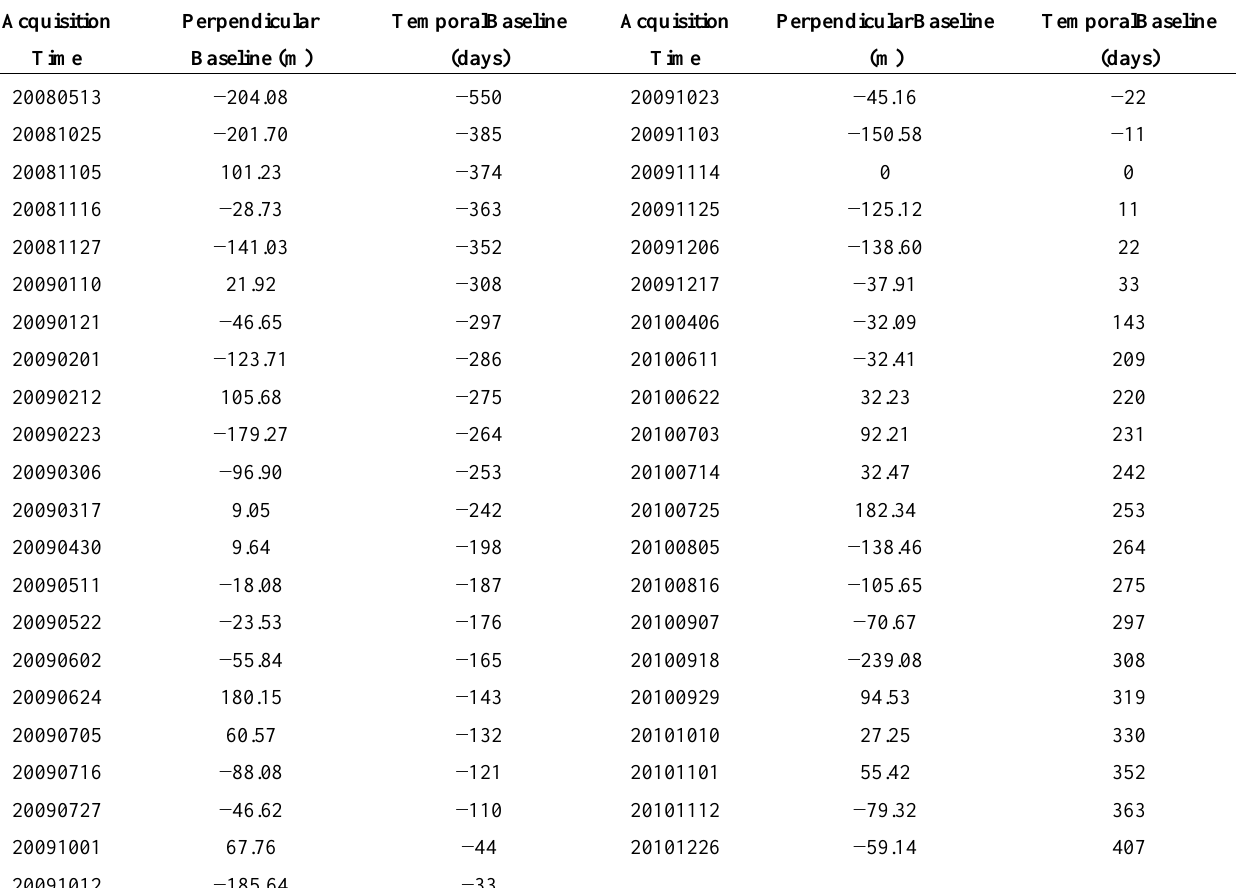
Table 2. TerraSAR-X (Stripmap) data used in this study covering Hong Kong, China; the image acquired in 14 November 2009 was selected as the reference for the dataset